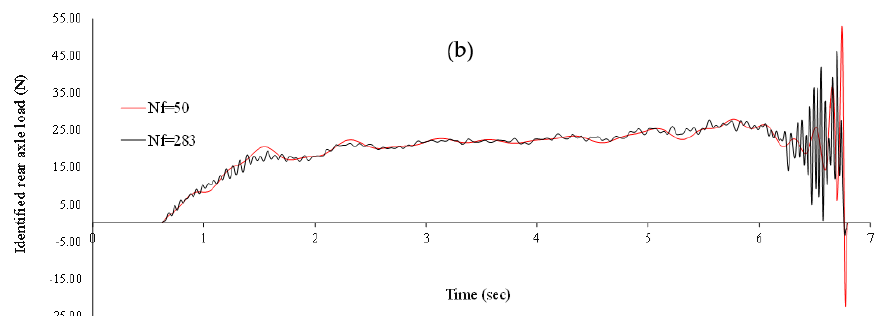
Figure 20. Comparison of the effects of a small N f and the optimized value on the identified axle